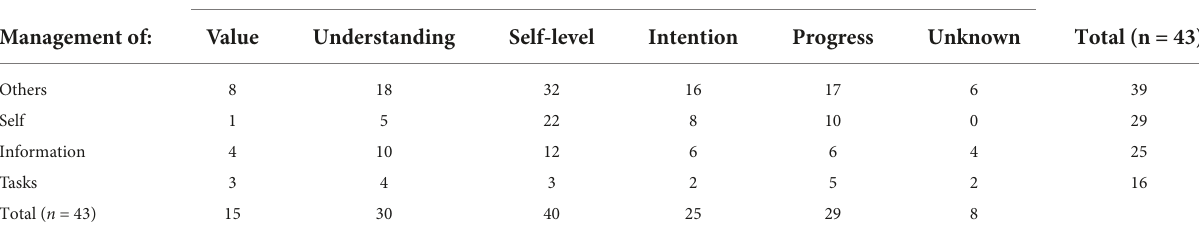
TABLE 4 Total learning categories (last row), total generic skills (last column), and the relation between learning categories and generic skills. Learning